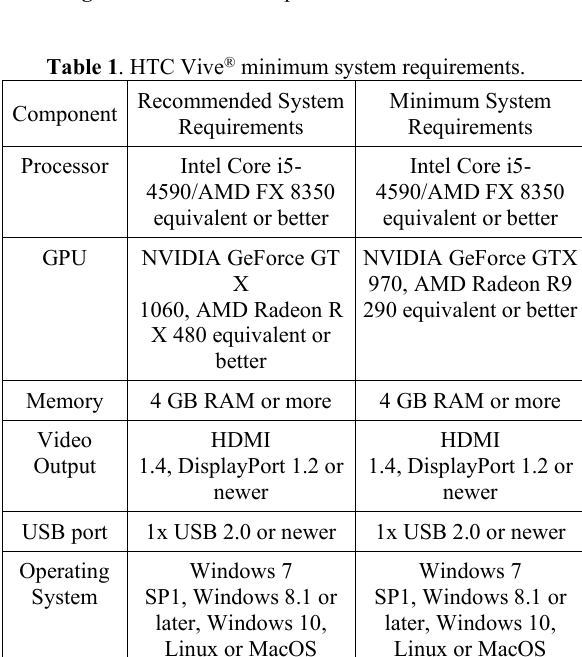
Figure 2 . The basic components of the HTC Vive ®